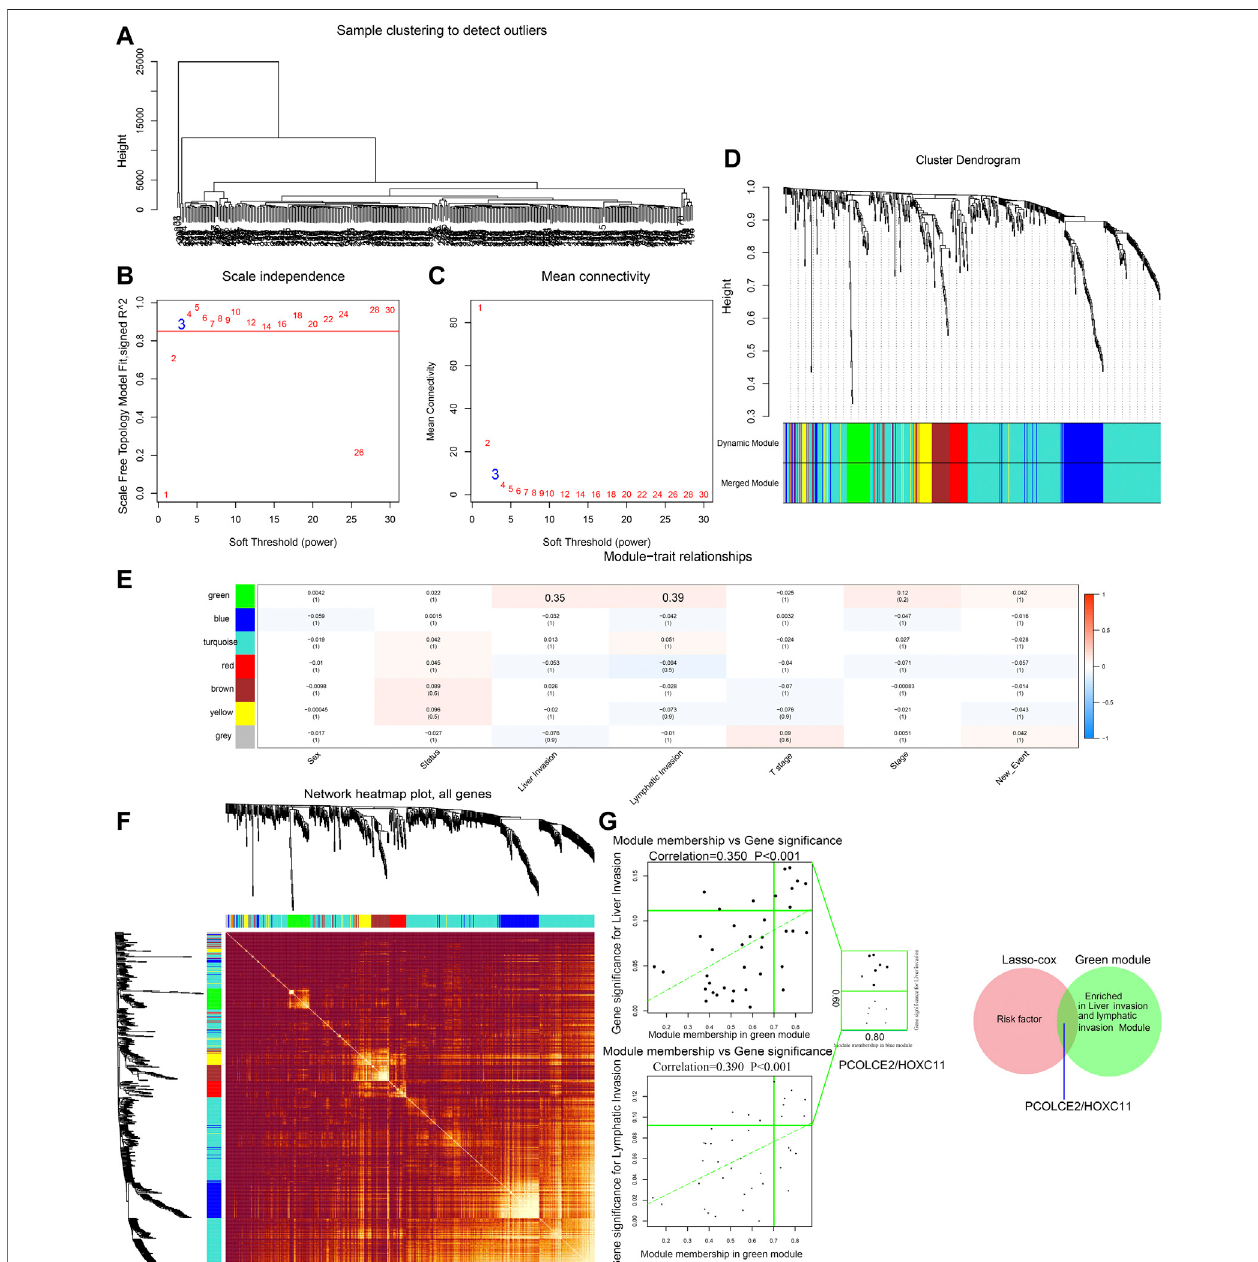
FIGURE6 | Screening ofkey phenotypic module and key genes byWGCNA. Hierarchical clustering dendrogramof samples from TCGA database (A) . Analysisof scale-free fi tindexandthemeanconnectivityforvarioussoft-thresholdingpowers.Testingthescale-freetopologywhen β (cid:1) 3 (B) .Hierarchicalclusteringdendrogramof genes with dissimilarity on the basis of topological overlap. Modules are the branches of the clustering tree (C) . Correlation between module genes and clinical traits. Each row corresponds to module genes, and columns represent clinical traits. Each cell contains the correlation and p value, and the green module containing PCOLCE2/HOXC11 are selected. The red bar represents positive correlation, while the blue bar represents negative correlation (D) . The heat map describes the TOM amongthe1000genesselectedinWGCNA.Genemodulesarerepresented byhorizontalandverticalcoordinates,andhighlyoverlappingmodulesaremarkedbyhigh- brightparts (E) . The green module containing PCOLCE2/HOXC11was correlated with COAD liver and lymphatic invasion. Ascatter plot wasmapped between GSand MM (green module and liver invasion) in COAD patients (F) . The intersected gene, PCOLCE2/HOXC11, was identi fi ed between risk factors in the risk model, and genes contained in green modules with Venn diagram (G)